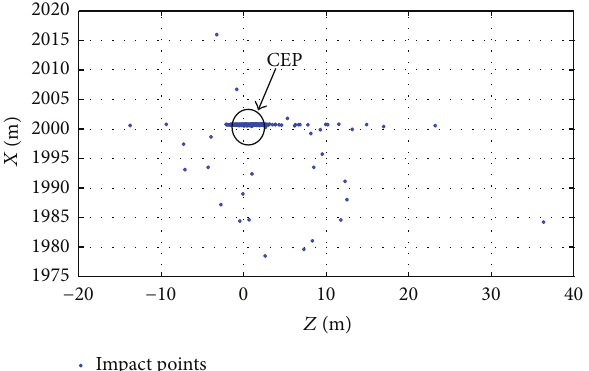
Figure 26: Result of the hardware in the loop simulation.